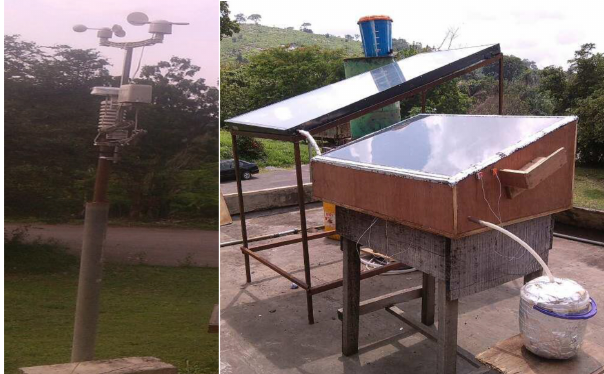
Figure 2. Experimental set-up of solar still coupled with flat plate